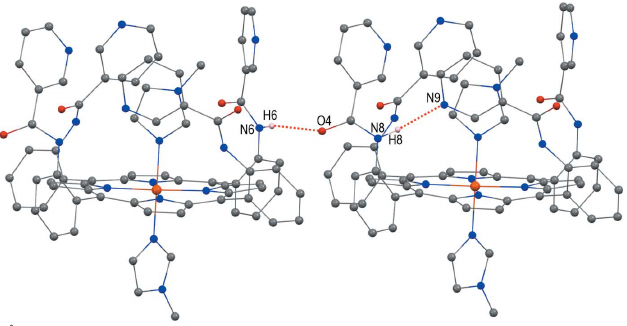
Figure 3 N—H (cid:2)(cid:2)(cid:2) O and N—H (cid:2)(cid:2)(cid:2) N interactions in the crystal structure of the title compound (see Table